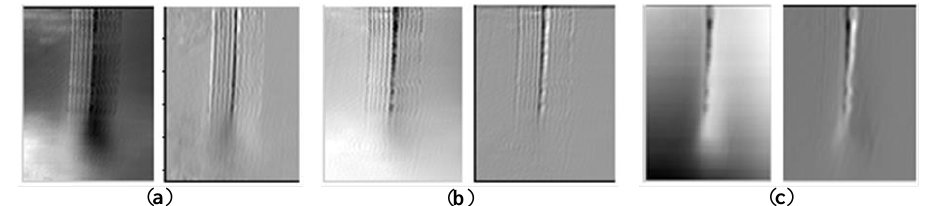
Figure 9. ( a ) Left: Original image with d ~ 1.7, ( a ) Right: Enhanced image with d ~ 1.7, ( b ) Left: Original image with d ~ 0.8, ( b ) Right: Enhanced image with d ~ 0.8 ( c ) Left: Original image with d ~ 0.2, ( c ) Right: Enhanced image with d ~ 0.2 mm.